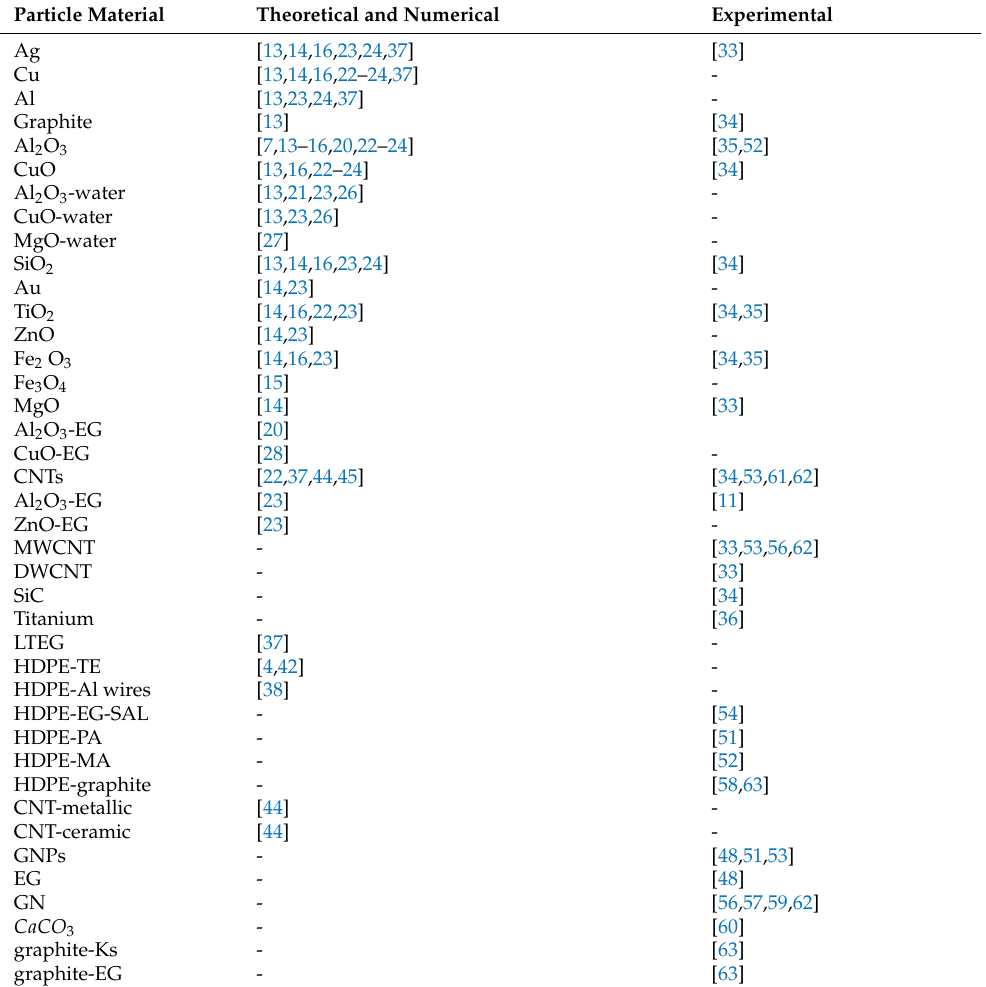
Table 7. Summary of parameters and analysis of heat